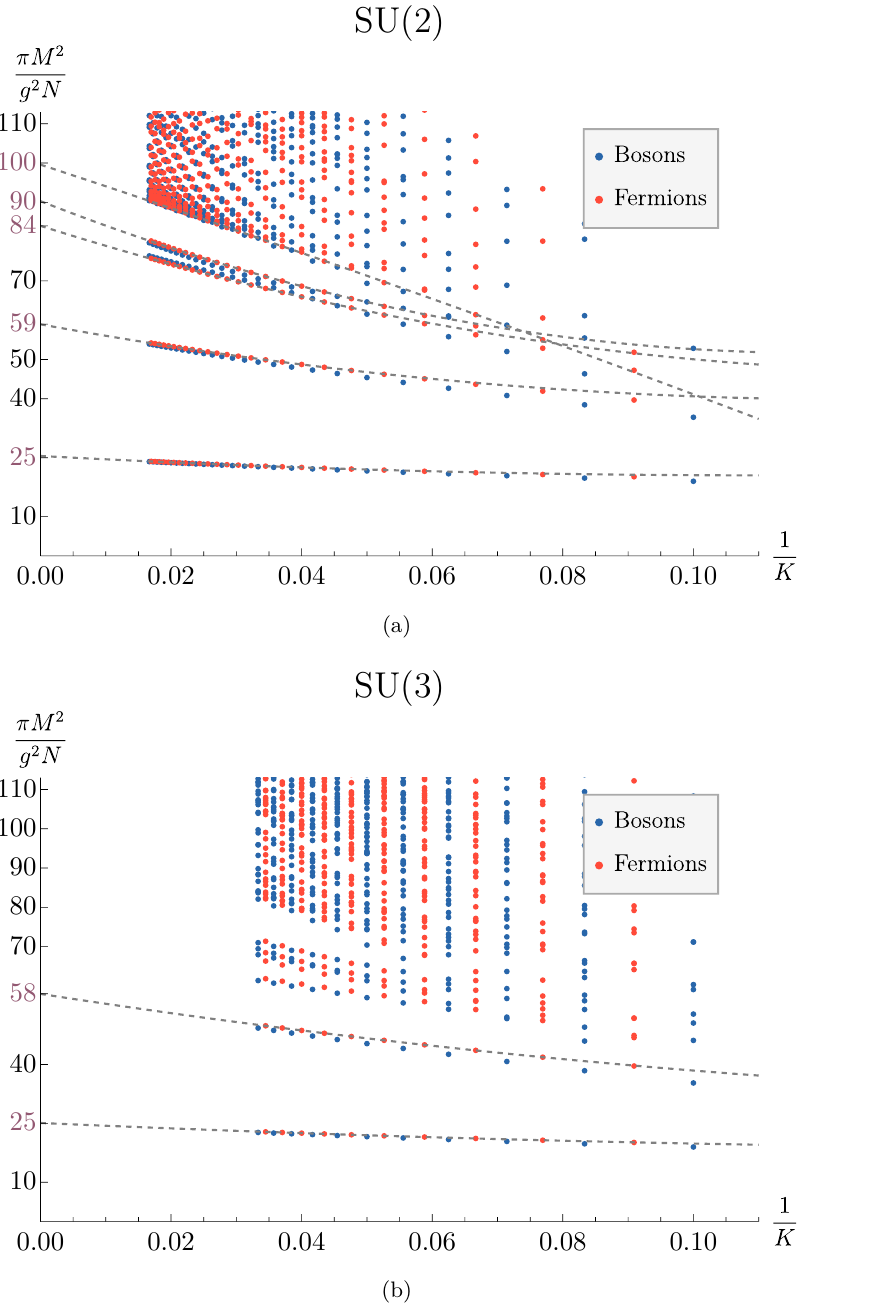
Figure 4 . The DLCQ spectra at y adj = 1 for SU(2) , SU(3) , SU(4) , and large N , with maximum K values of 60, 30, 25, and 41, respectively. The spectra exhibit the expected supersymmetry [19, 31]. The lowest two doublets appear at similar masses for all N . For SU(2) , we also extrapolate an additional two bound states and the onset of the two-particle continuum at twice the mass of the lowest